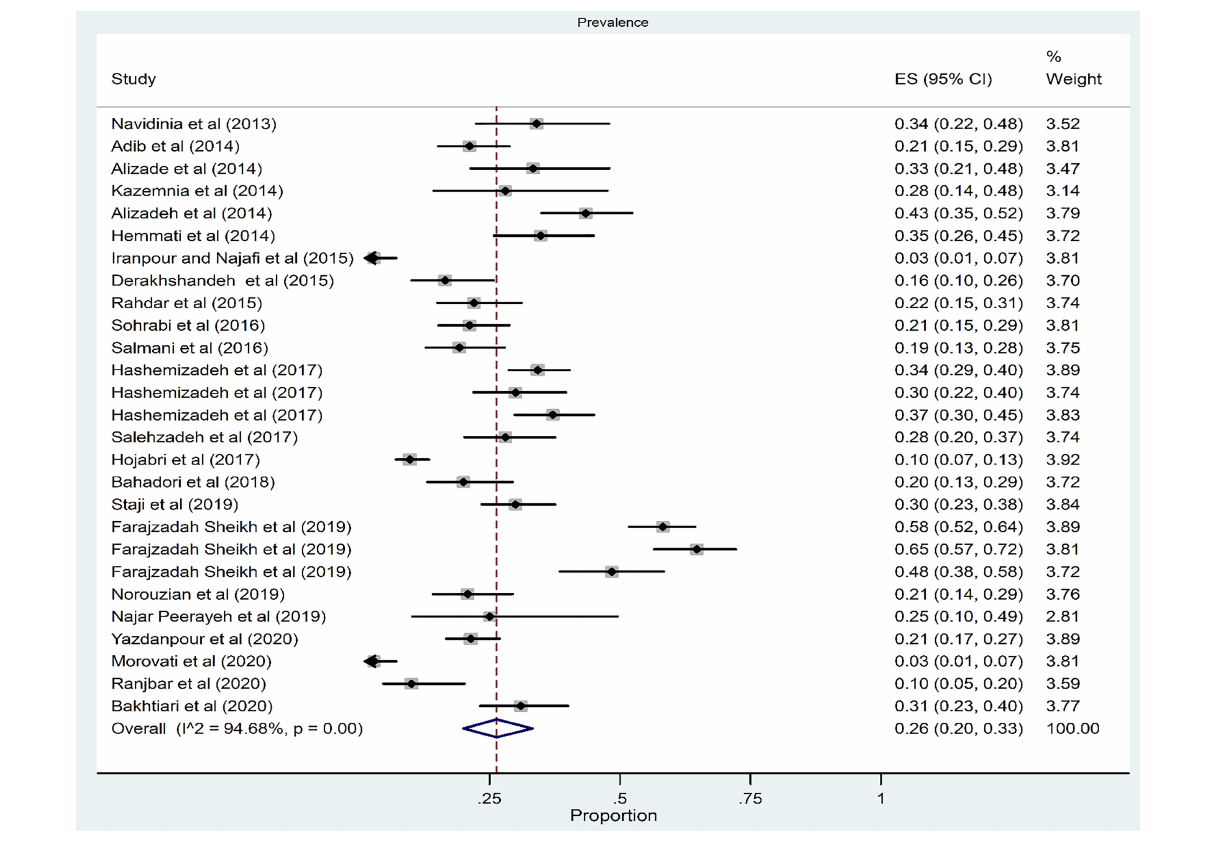
FIGURE 4 | Forest plot of the meta-analysis of phylogroup D prevalence among UPEC